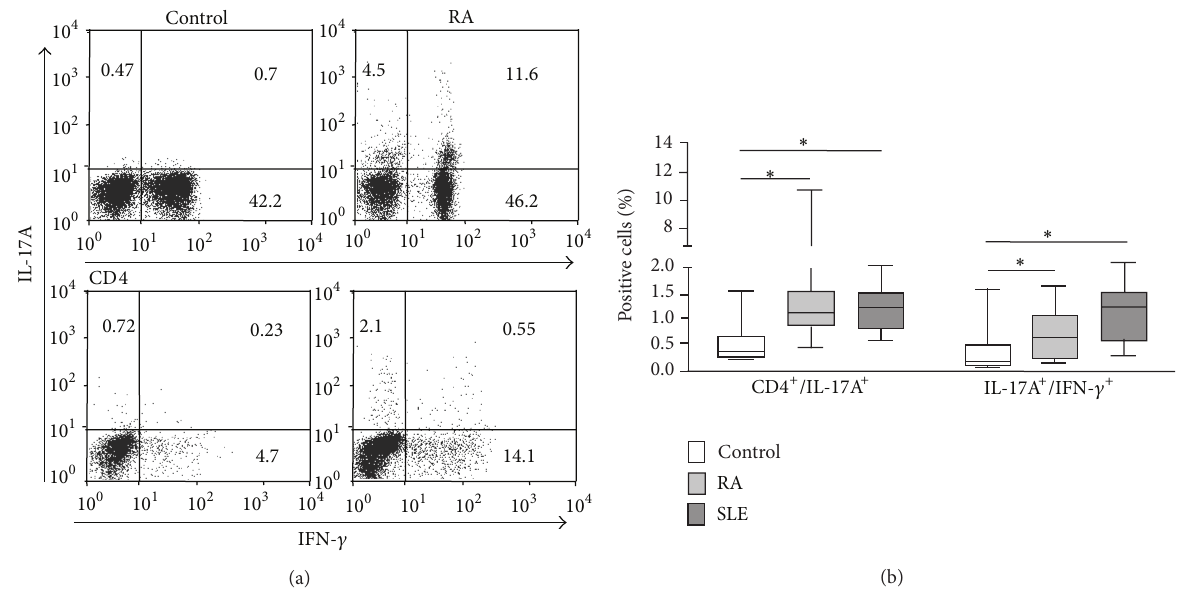
Figure 2: Quantification of Th17 cells in the peripheral blood from patients with RA and SLE. Peripheral blood mononuclear cells from patients with RA and SLE and healthy controls were immunostained for the determination of Th17 (CD4+ IL-17A+) and Th1/Th17 (CD4+ IL-17A+ IFN- 𝛾 +) lymphocytes, and analyzed by flow cytometry, as stated in materials and methods. Dot plots from cells of a representative patient with RA and a healthy control are shown in (a), and the median and interquartile range of the percent of positive cells in (b). Numbers in quadrants correspond to the percent of events. ∗ 𝑃 < 0.05